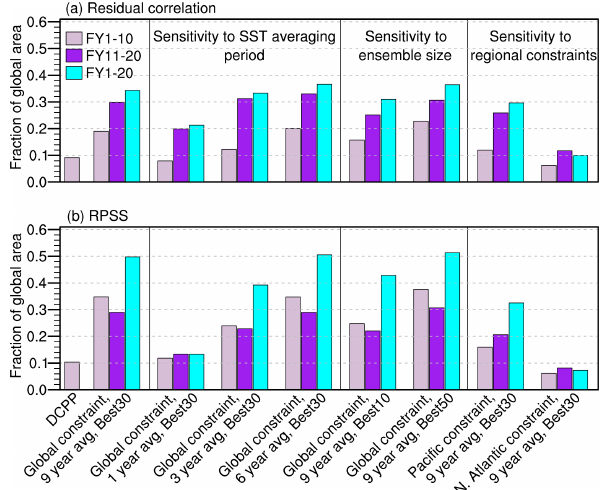
Figure 5. Fraction of global area where the added skill in near- surface temperature (measured as residual correlation and RPSS against the unconstrained CMIP6 ensemble as reference) of DCPP and the constrained ensembles is positive and statistically signifi- cant at the 95% confidence level for residual correlation (a) and for RPSS (b) . Different colors represent different forecast